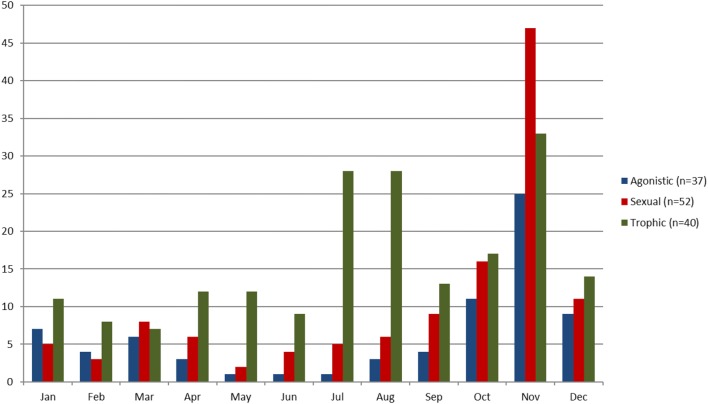
Histogram of the seasonality of IDWS (sexual, agonistic and trophic) in Cosrsica during 2013 observed by farmers and hunters.